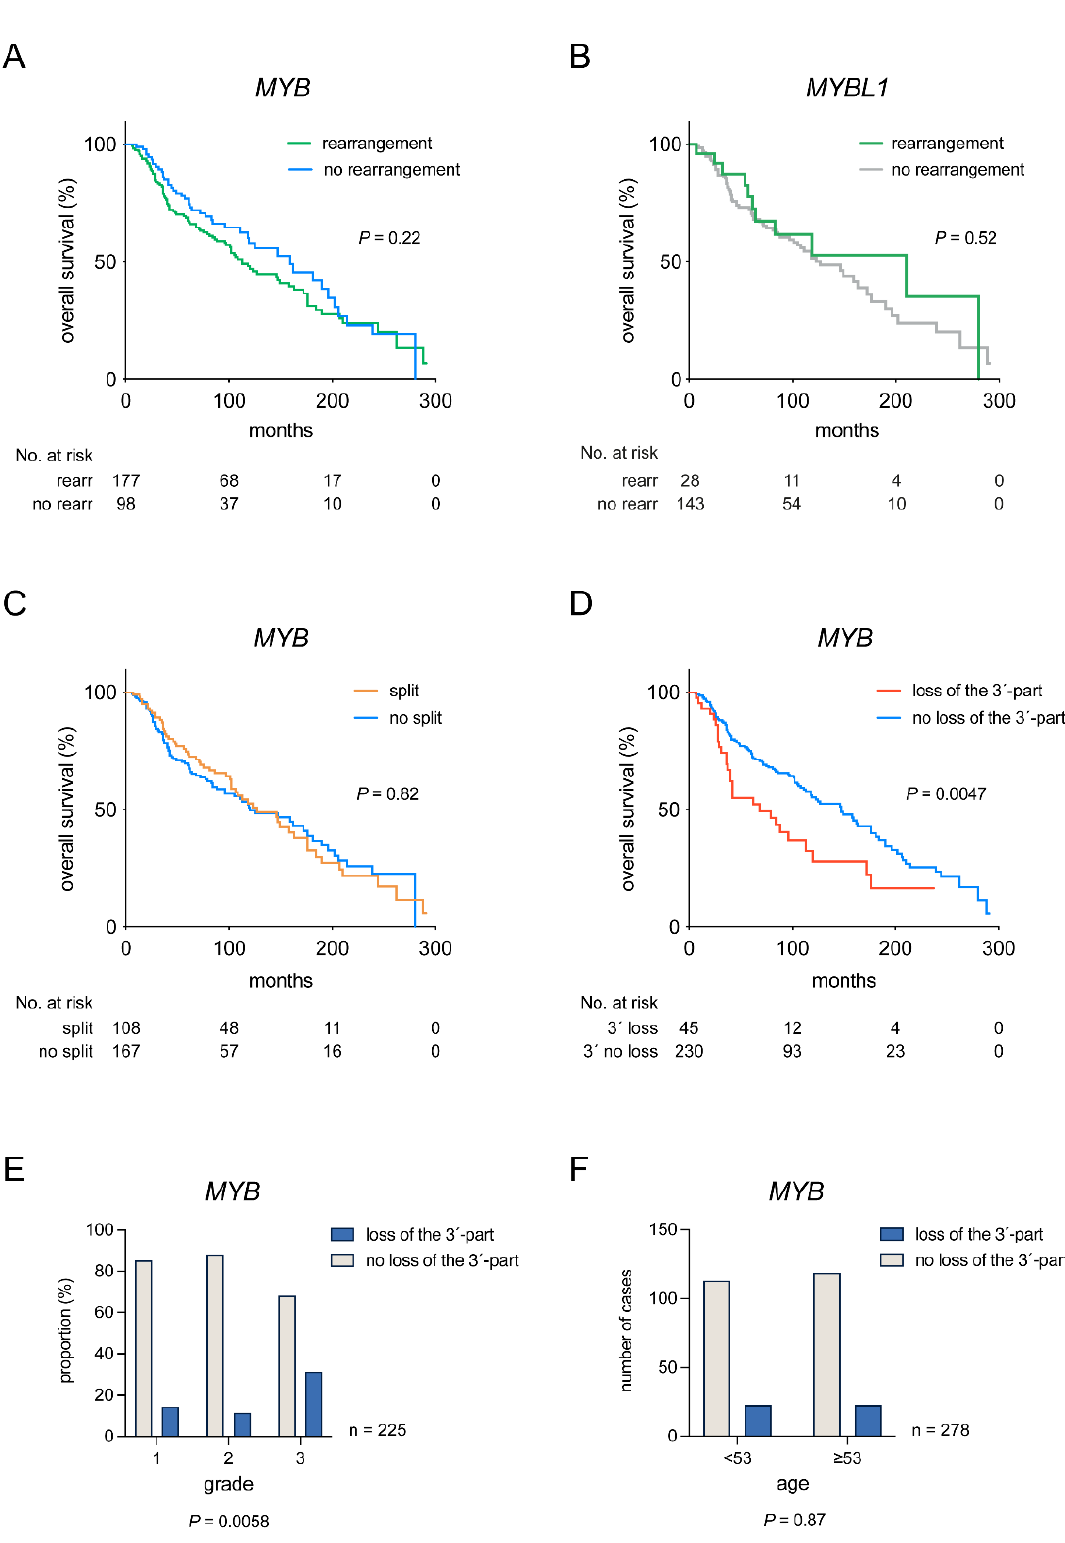
Figure 4. Prognostic significance of MYB and MYBL1 alterations in ACC. ( A ) OS in ACC patients with or without MYB rearrangements. ( B ) OS in ACC patients with or without MYBL1 rearrangements. ( C ) OS of ACC patients with or without MYB split signal. ( D ) OS of ACC patients with or without loss of the 3 ′ -part of MYB . ( E ) Distribution of ACC cases with or without loss of the 3 ′ -part of MYB by tumor grade. ( F ) Distribution of ACC cases with or without loss of the 3 ′ -part of MYB by median age.